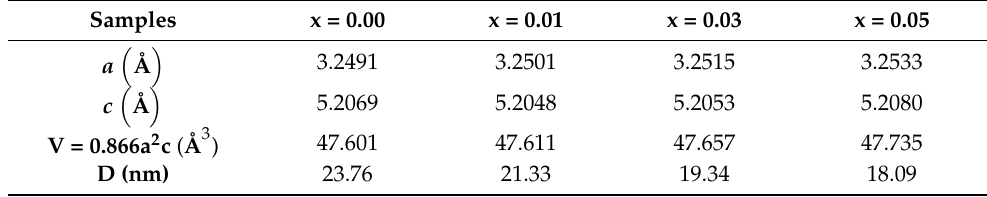
Table 1. Structural parameters deduced from the XRD analysis.